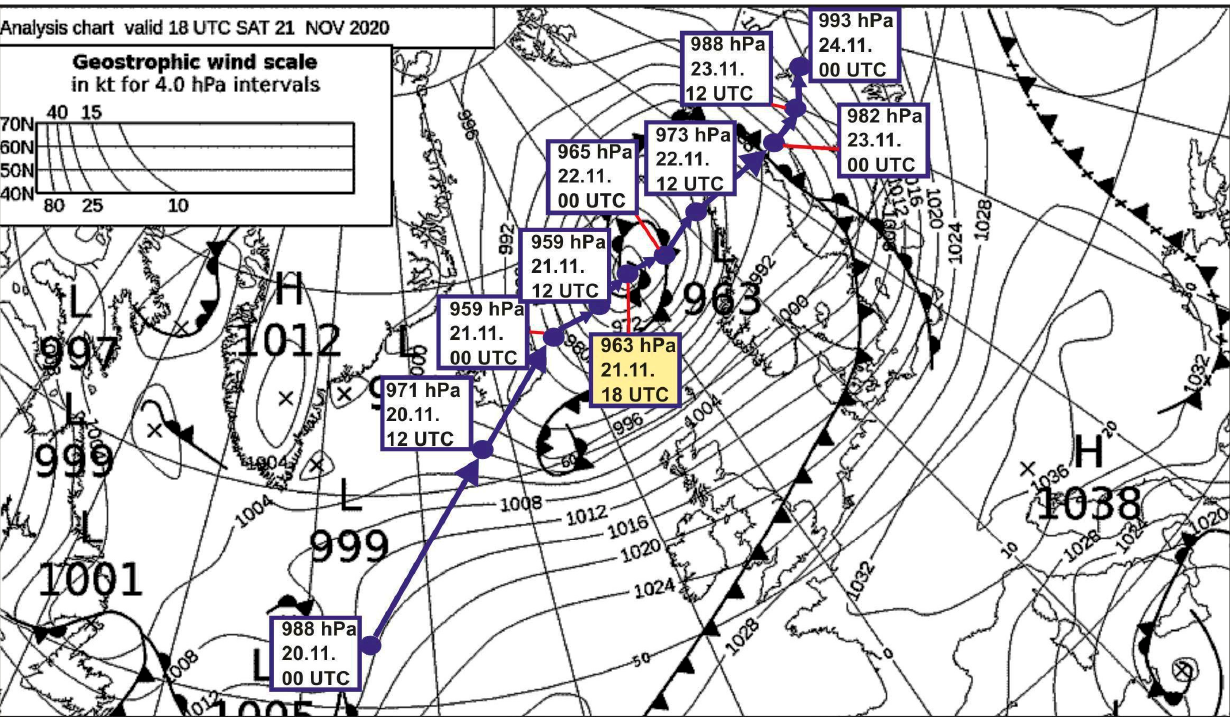
Figure 6. The course of the low pressure system on 20–24 November 2020 together with the main synoptic situation on 21